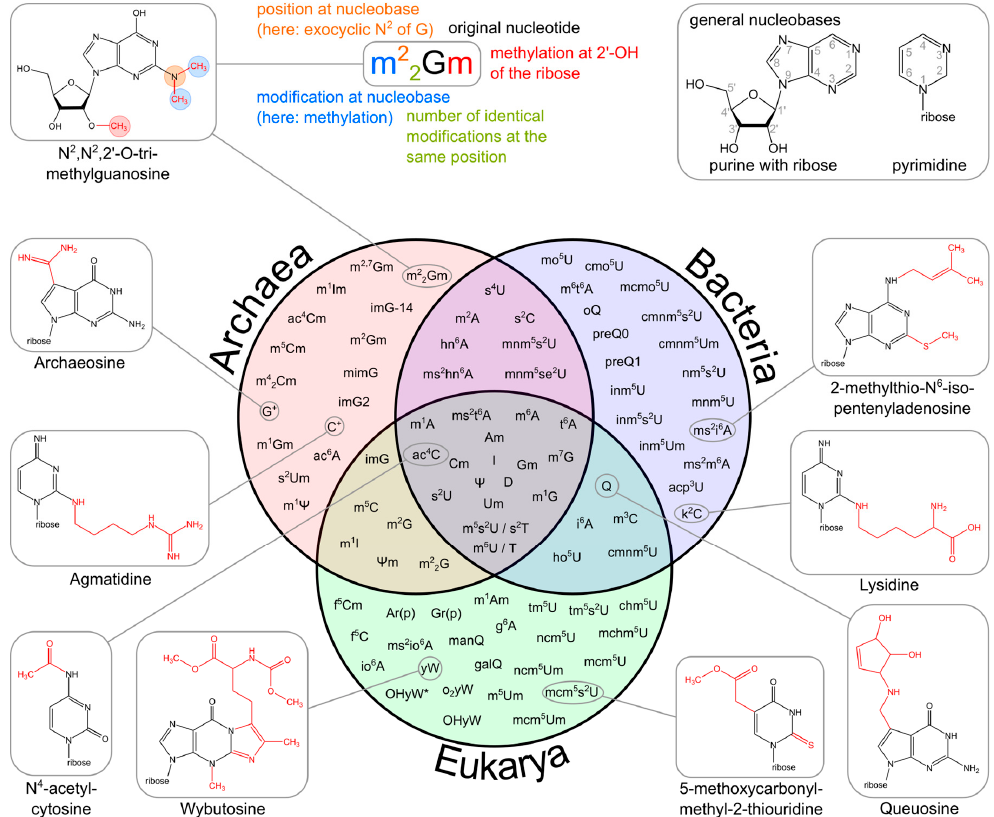
Figure 2. Variability of tRNA modifications. The upper part of the image illustrates the systematic abbreviation of RNA modifications with N 2 , N 2 ,2 ′ ‐ O ‐ trimethylguanosine (m 22 Gm) as an example and also shows the atom numbering in the purine and pyrimidine rings as well as in the ribose. An abbreviation in front of the base letter describes a base modification, whereas letters after the base stand for ribose alterations. Superscripted numbers specify the position at the base and subscripted numbers indicate the frequency of identical modification at the same